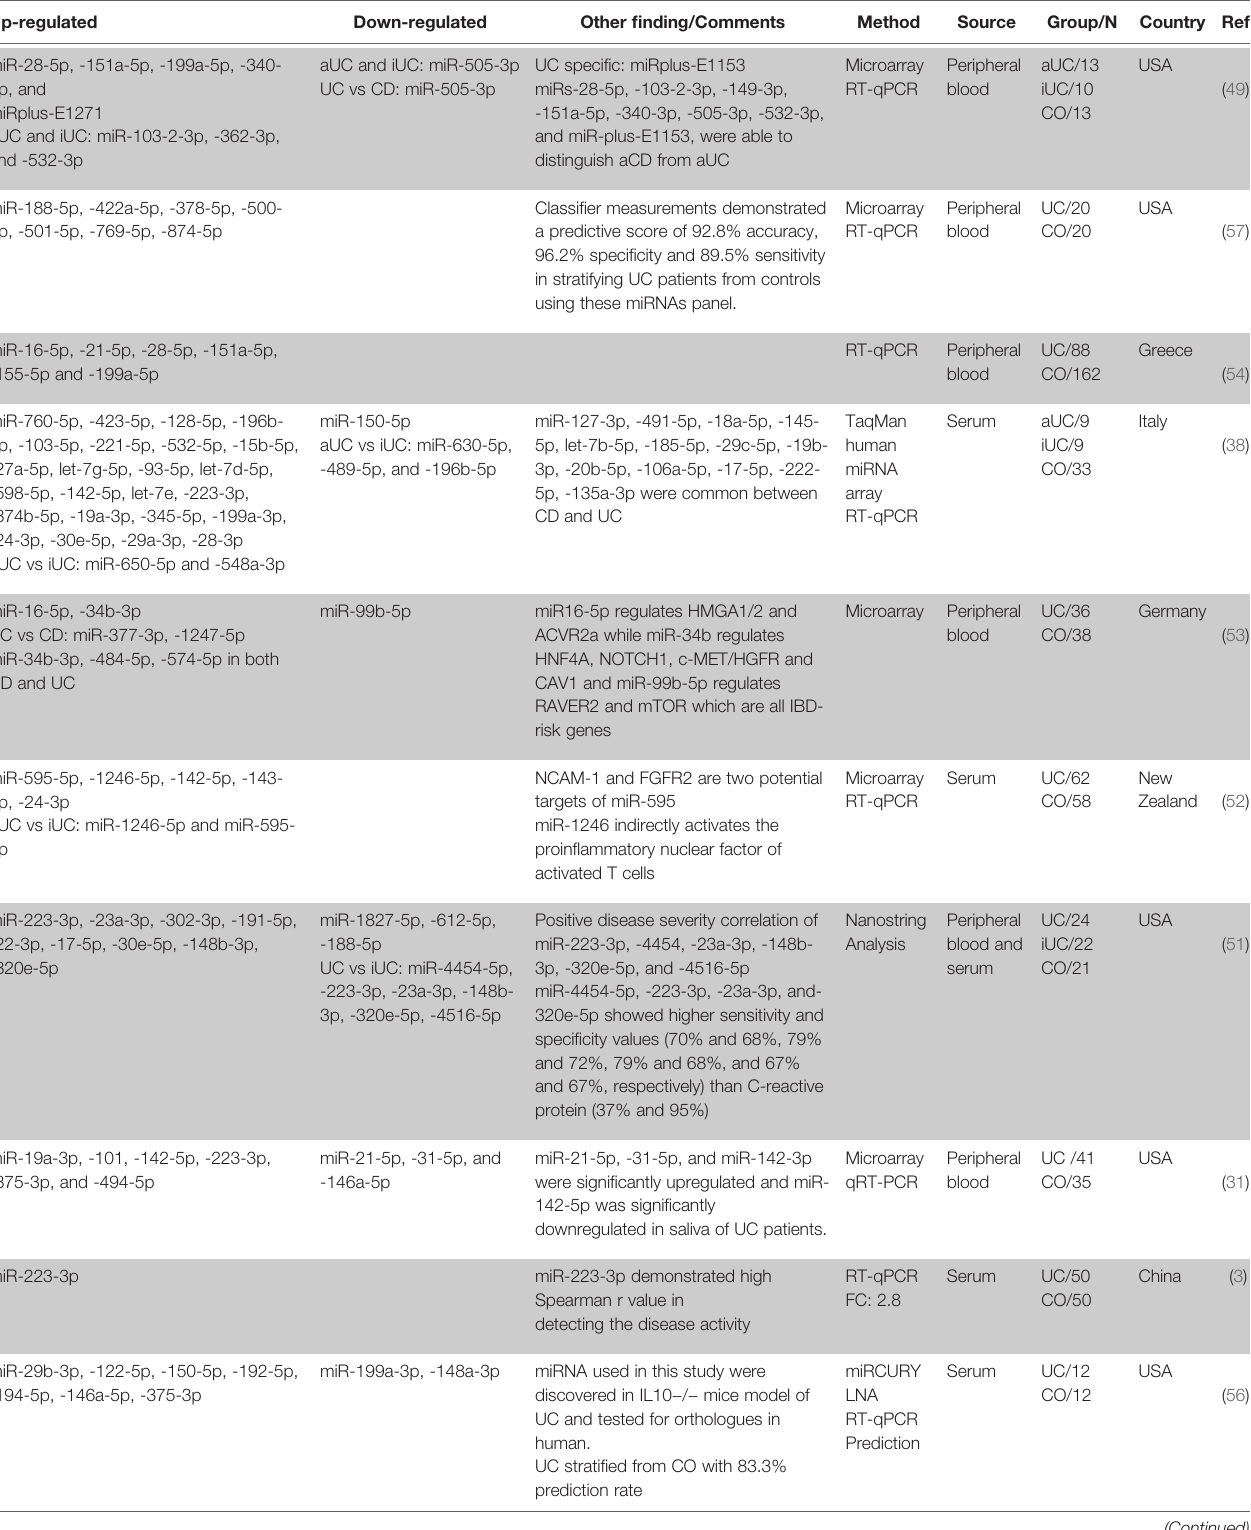
TABLE 3 | Differentially expressed miRNAs in human UC peripheral blood based on literature review.